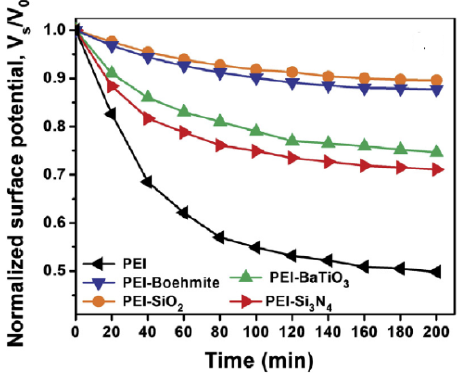
Figure 8. Normalized surface potential vs. time of hybrid membranes at room temperature (Reprinted with permission from [59]. Copyright 2015 Elsevier).